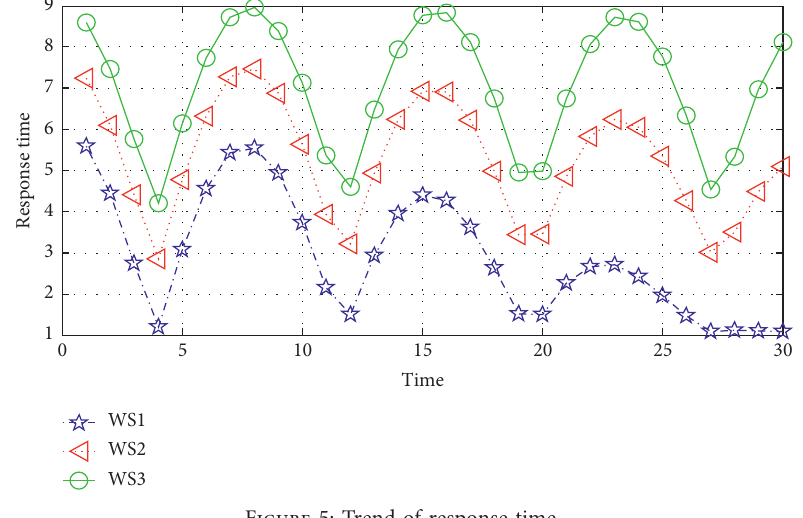
Figure 5: Trend of response time.